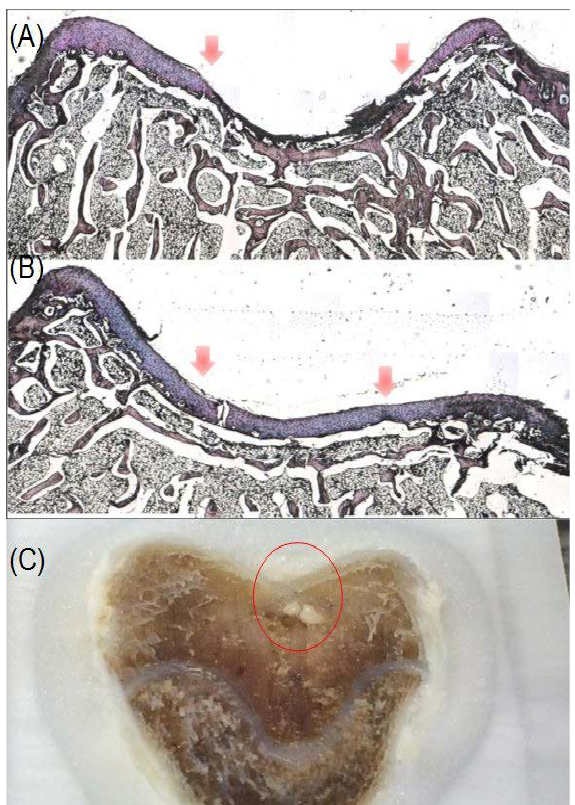
Figure 12. The histological staining (Alcian blue/PAS staining) and specimen of cartilage sections of rabbit after 12 weeks after implantation. ( A ) The control group with only bone formation; and ( B ) the experimental group showed bone and hyalin cartilage regeneration (arrow means defect); ( C ) The specimen of the experimental group showed good cartilage and bone regeneration on the surface layer and residual un-degraded scaffold in the deep layer.